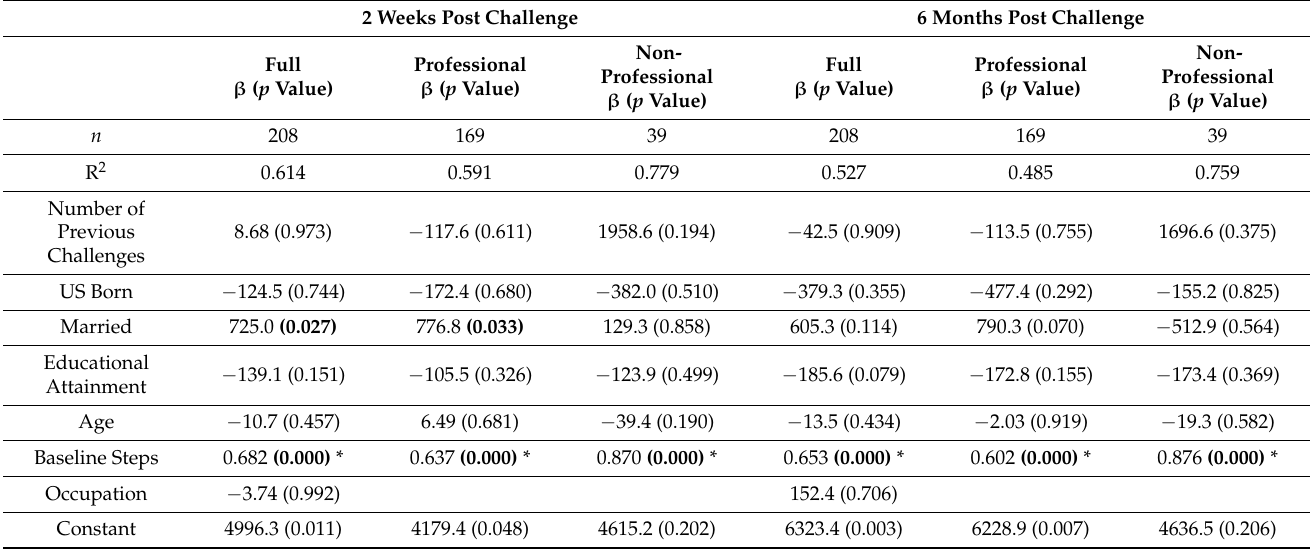
Table 2. Adjusted jackknife variance estimated regression results for 2-week and 6-month step counts by occupation status (professional vs.